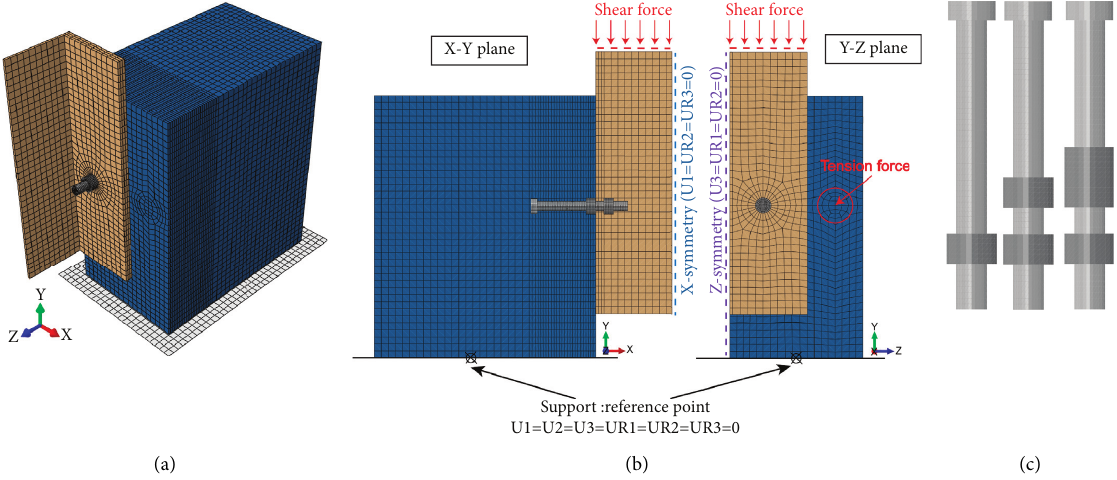
Figure 3: The FE model: (a) one-quarter of the model; (b) the boundary and loading conditions; (c) bolted shear